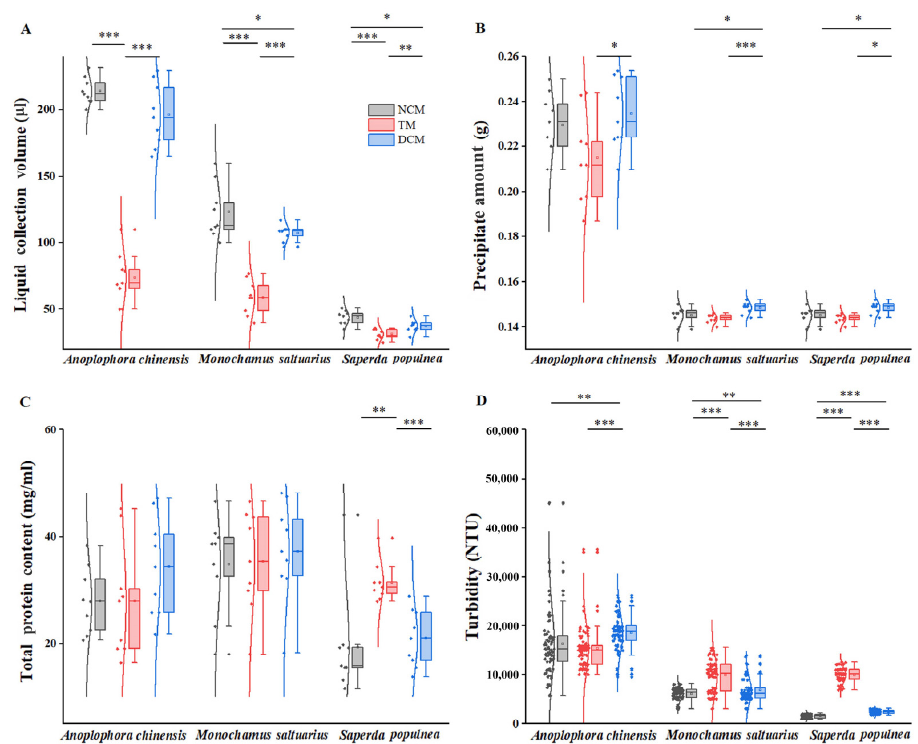
Figure 3. Results of three haemolymph collection methods for three species. ( A ): collection volumes; ( B ): precipitate amounts; ( C ): total protein contents; ( D ): turbidity. NCM, net centrifugation method; TM, tearing method; DCM, double centrifugation method. Samples, black dots; ±SD, hollow dots; median, middle line inside each box; IQR (interquartile range), the box containing 50% of the data; whiskers, 1.5 times the IQR. Normal of distribution, curved line. * p < 0.05; ** p < 0.01; *** p < 0.001.